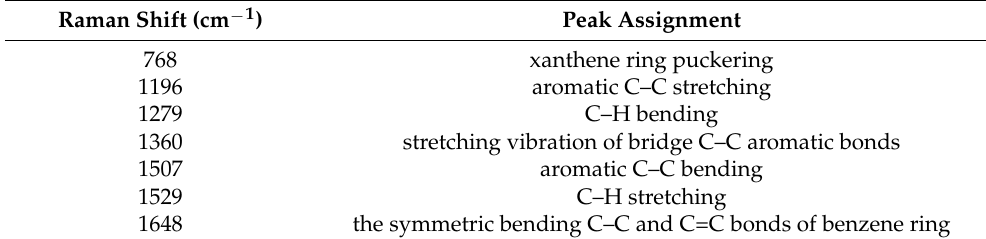
Figure 6. ( a ) Comparison of the SERS spectra of 10 − 5 M RhB on ZnO/Ag substrates with different Ag contents. ( b ) SERS spectra on different substrates with 10 − 5 M RhB. Table 1. Main peaks of RhB and their